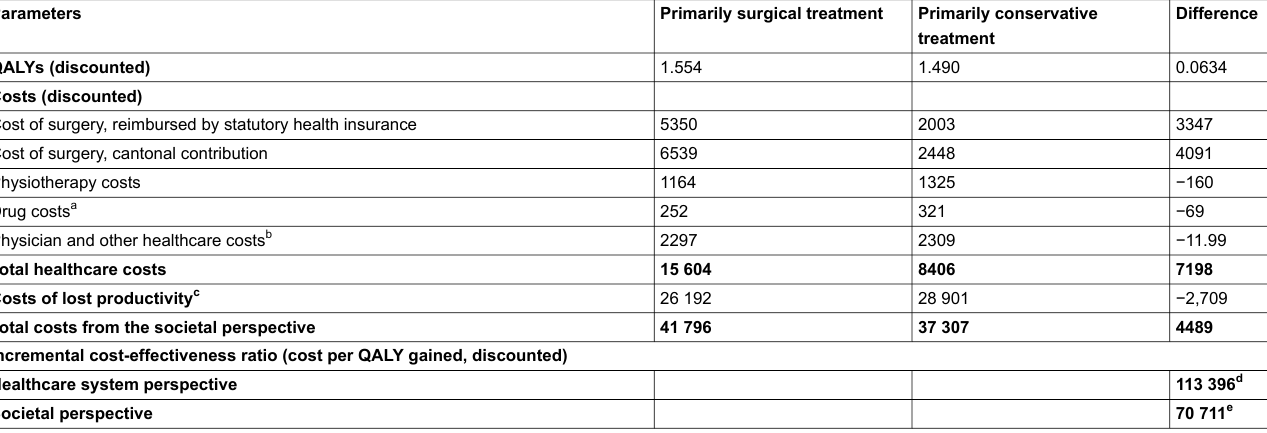
Table 1: Base-case results (healthcare system and societal perspective) of the decision model comparing primarily surgical treatment with primarily conservative treatment approach. The results are expressed per person. Parameters